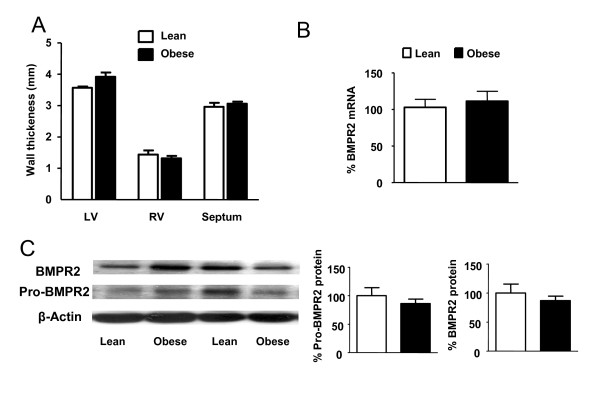
Heart wall thickness and BMPR2 expression. (A) Left ventricular (LV), right ventricular (RV) and septal wall thickness from lean (n = 8) and obese (n = 7) Zucker rats. (B) BMPR2 mRNA expression in resistance PA of lean and obese (n = 5) analyzed by RT-PCR and normalized by β-actin expression. (C) BMPR2 precursor (~115 KDa) and mature (~75 KDa) protein expression from obese and lean Zucker lungs (n = 8) analyzed by Western blot and normalized by β-actin expression. Results indicate mean ± s.e.m.